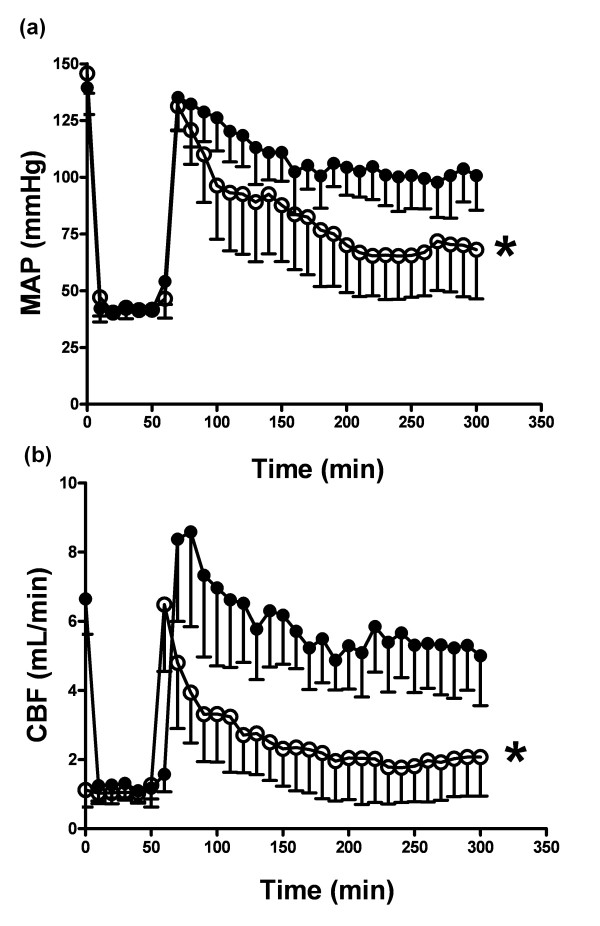
Hemodynamic measurements. Mean arterial blood pressure (MAP) and carotid blood flow (CBF) in hemorrhagic shock (HS)/saline group (white circle) and hemorrhagic shock/NaHS group (black circle) rats recorded during 300 minutes monitoring period. Data are expressed as mean ± SD of n = 11 rats for HS/NaHS group, n = 11 rats for HS/saline group. *P < 0.05, significantly different between HS-saline and HS-NaHS groups.